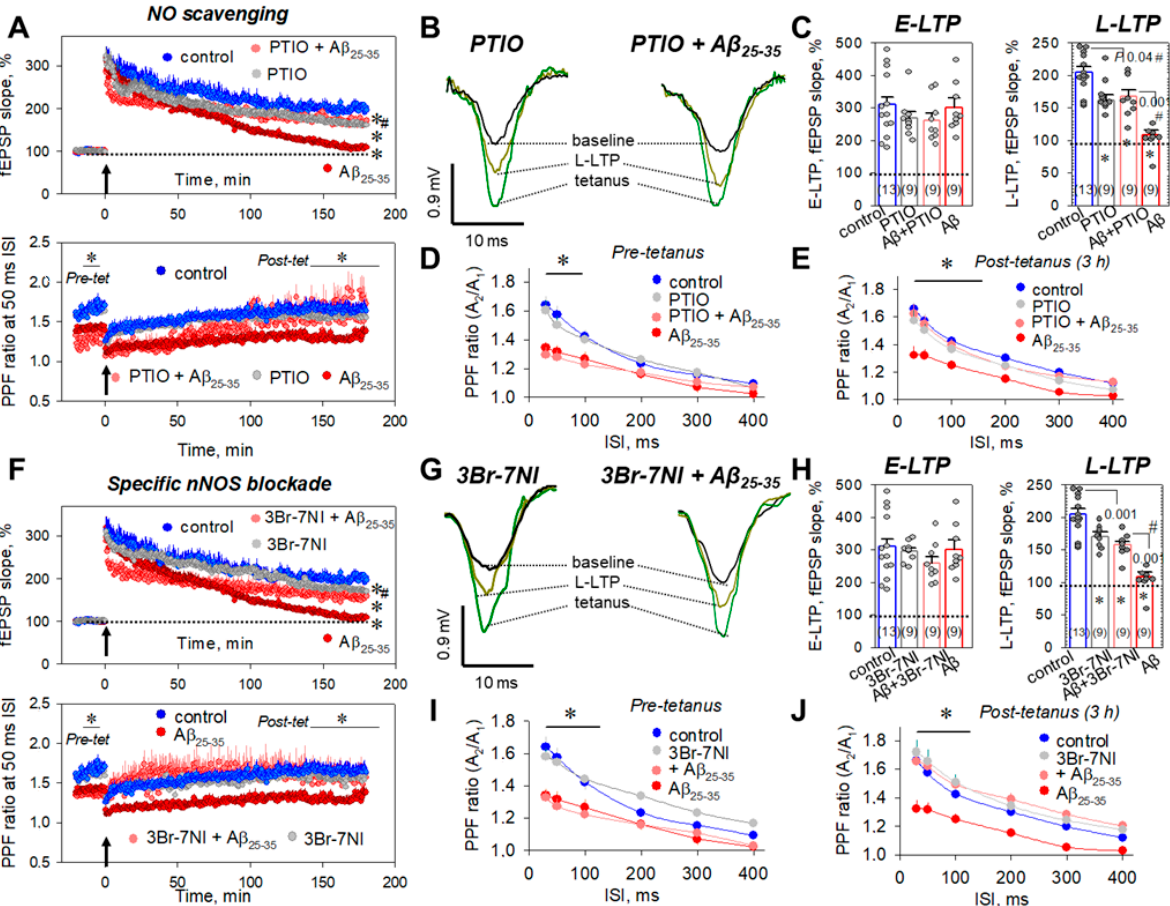
Figure 8. Selective disruption of NO signaling during the A β 25-35 -dependent impairment of hip- pocampal synaptic plasticity. ( A ) Averaged curves for control slices (blue circles, n = 13), PTIO-treated slices (50 µ M, gray circles, n = 9), A β 25-35 -treated slices (dark red circles, n = 9), and PTIO + A β 25-35 -treated slices (red circles, n = 9). Arrow at 0 min indicates start of tetanic stimulation; dotted line 100% represents normalized fEPSPs corresponding to the pre-tetanic level. Bottom panel repre- sents paired-pulse facilitation (PPF) curves at the 50 ms ISI. ( B ) Typical fEPSP responses of studied groups for pre-tetanic levels (baseline), at the start of post-tetanic recordings (tetanus) and 180 min after LTP induction (L-LTP). ( C ) Summarized statistics for (A) curves during early phase (E-LTP, 0– 3 min) and late phase (L-LTP, 178–180 min) of long-term potentiation. * denotes p < 0.05 for compar- ing of the group with control; # indicates p < 0.05 for comparison of groups between themselves. The